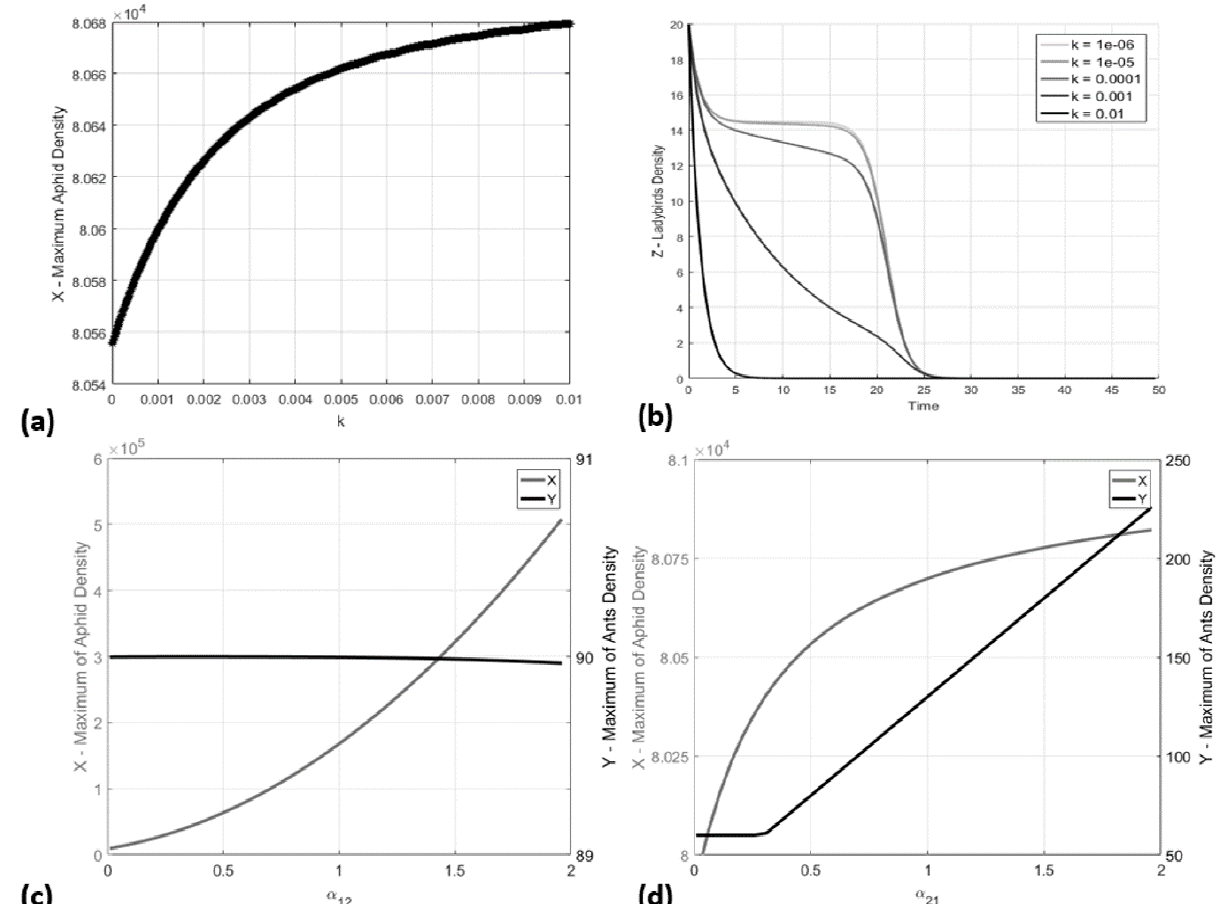
Figure 4. (a) Maximum of the aphid density versus the coefficient of interspecific competition; (b) Evolution of the ladybird density, evaluated for k = 10 − 2 ,10 − 3 ,10 − 4 ,10 − 5 ,10 − 6 (progressively darker colors are assigned to greater k values). (c) Maximum of aphids (gray) and ants (black) density versus α 12 . (d) Maximum of aphid (gray) and ants (black) density versus α 21